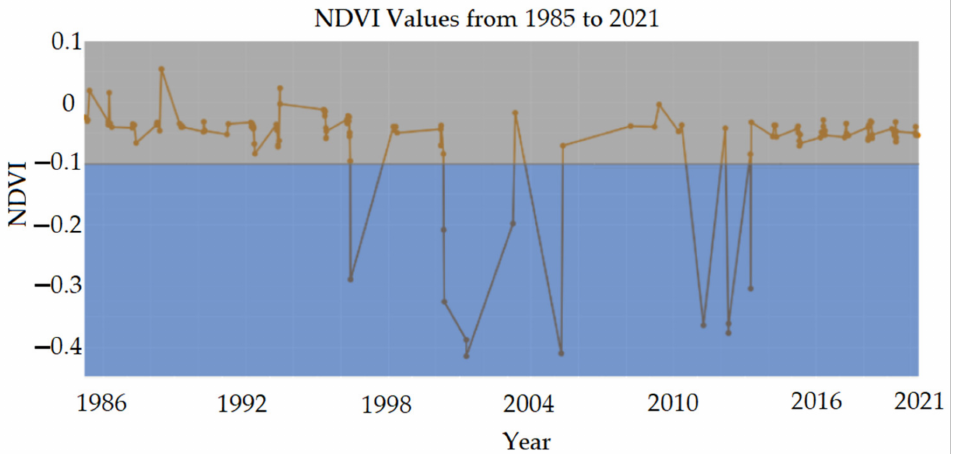
Figure 11. NDVI Values from 1985 to